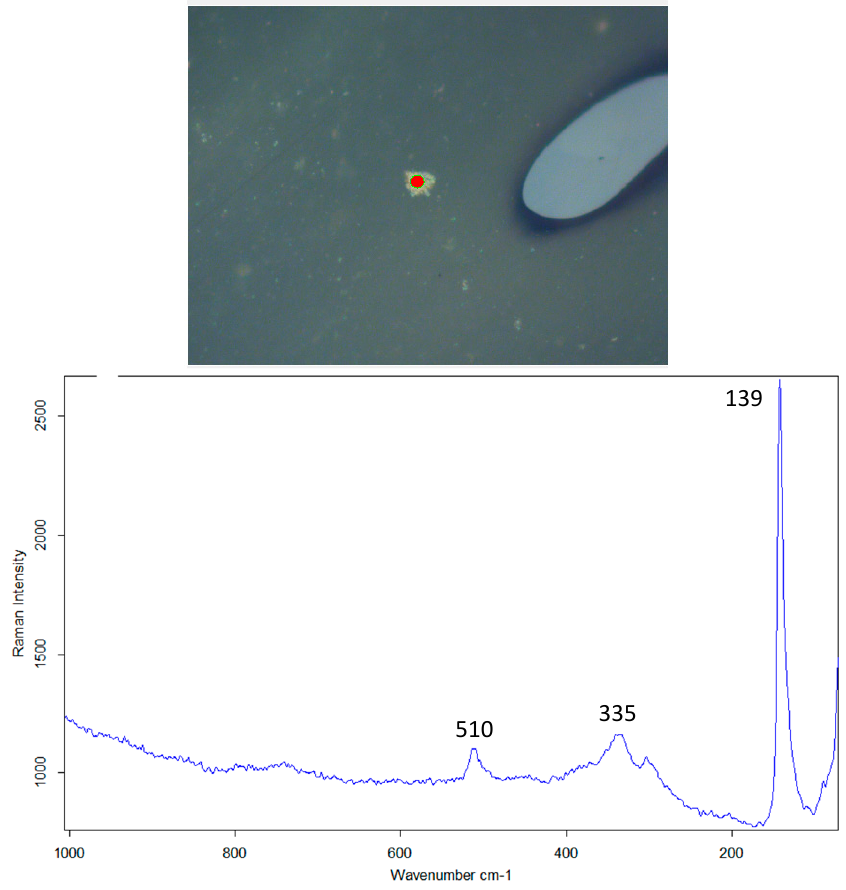
Figure 12. Raman spectrum acquired on lead antimonate crystals, with bands at 139, 335, and 510 cm − 1 , consistent with bindhemite, cubic pyrochlore Pb 2 Sb 2 O 7 [55] SSV_Y1 yellow sample from the monastery of San Severo in Classe, Ravenna, Italy—unpublished data).